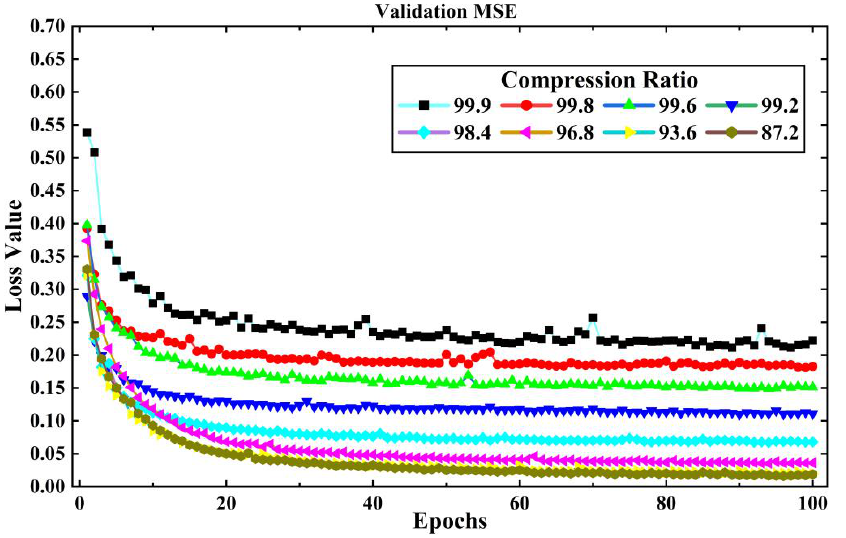
Figure 8. The changing trend of experimental loss value MSE with validation epochs under different CR for − CG lightning signal collected by sensor array. CR for − CG lightning signal collected by sensor